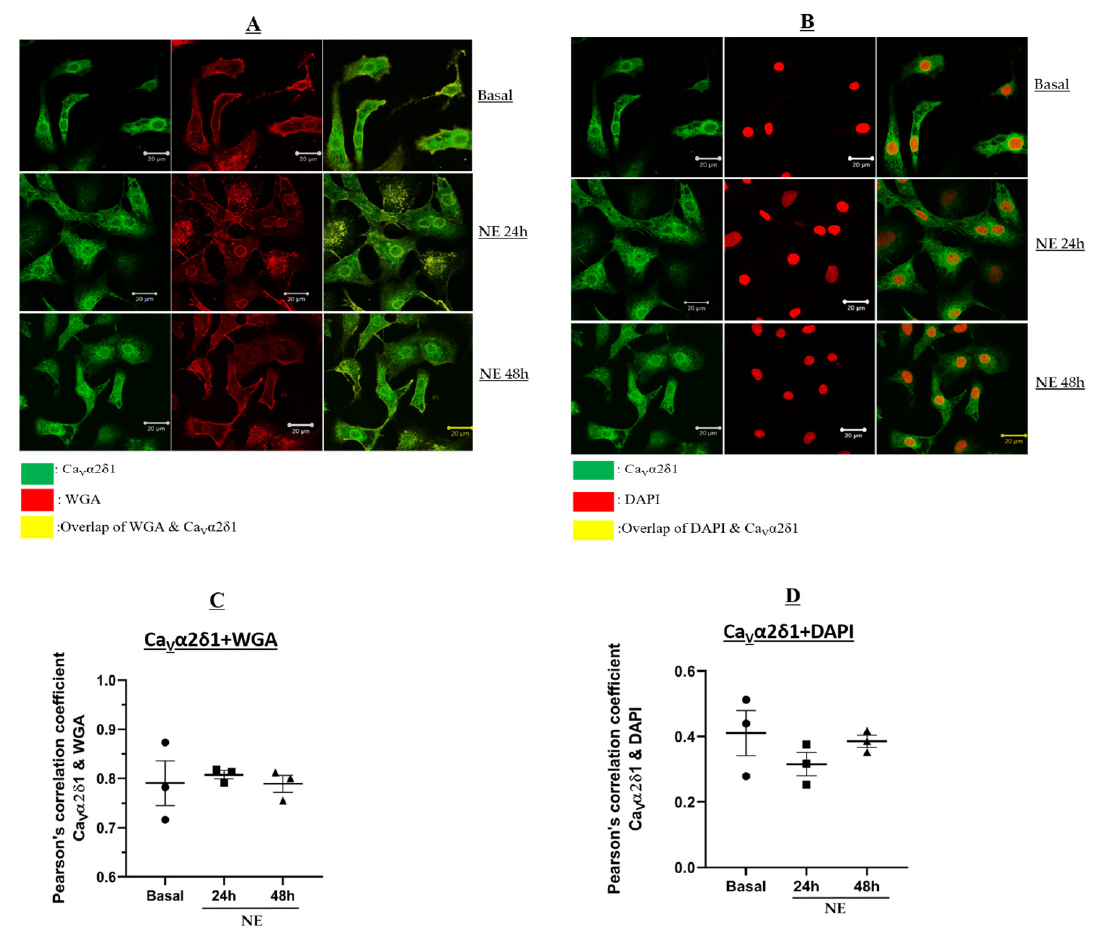
Figure 5. Neonatal rat cardiomyocytes in basal condition or treated with NE for 24–48 h. WGA- Alexa 647 was added to live cardiomyocytes at room temperature, followed by fixation with 2% Paraformaldehyde for 20 min at room temperature. Cardiomyocytes were then permeabilized with 0.2% Triton-X. Primary antibody: mouse anti-Troponin-T and rabbit anti-Ca V α2δ1 were added for 90 min at room temperature followed by overnight incubation at 4 °C. This was followed by incubation of secondary antibodies: Goat anti-mouse Alexa 555; Donkey anti-rabbit Alexa 488, and DAPI for 90 min at room temperature in the dark. Images were captured by microscope with 20× objective. Images were analyzed using ZEN software. ( A ) Images showing colocalization of WGA and Ca V α2δ1. Green: Ca V α2δ1; Red: WGA; Yellow: Overlap between Ca V α2δ1 and WGA. ( B ) Images showing colocalization of DAPI and Ca V α2δ1. Green: Ca V α2δ1; Red: DAPI; Yellow: Overlap be- tween Ca V α2δ1 and WGA. ( C ) Graph showing Pearson’s correlation coefficient of the overlap be- tween WGA and Ca V α2δ1. ( D ) Graph showing Pearson’s correlation coefficient of the overlap be- tween DAPI and Ca V α2δ1. Pearson’s correlation coefficient (r) of the overlap is determined using ImageJ.